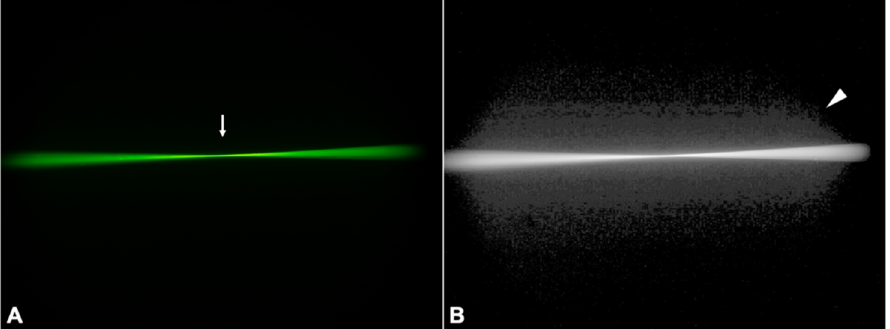
Figure 4. Ray propagation ( A ) and light scattering ( B ) of the glistenings-IOL. The arrow indicates its focal point, while the arrowhead points to its extent of scatter light.